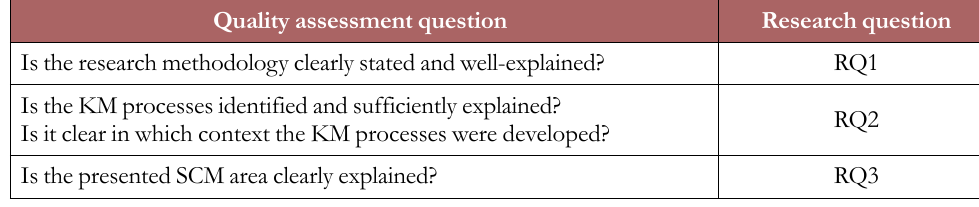
Table 3. Quality assessment